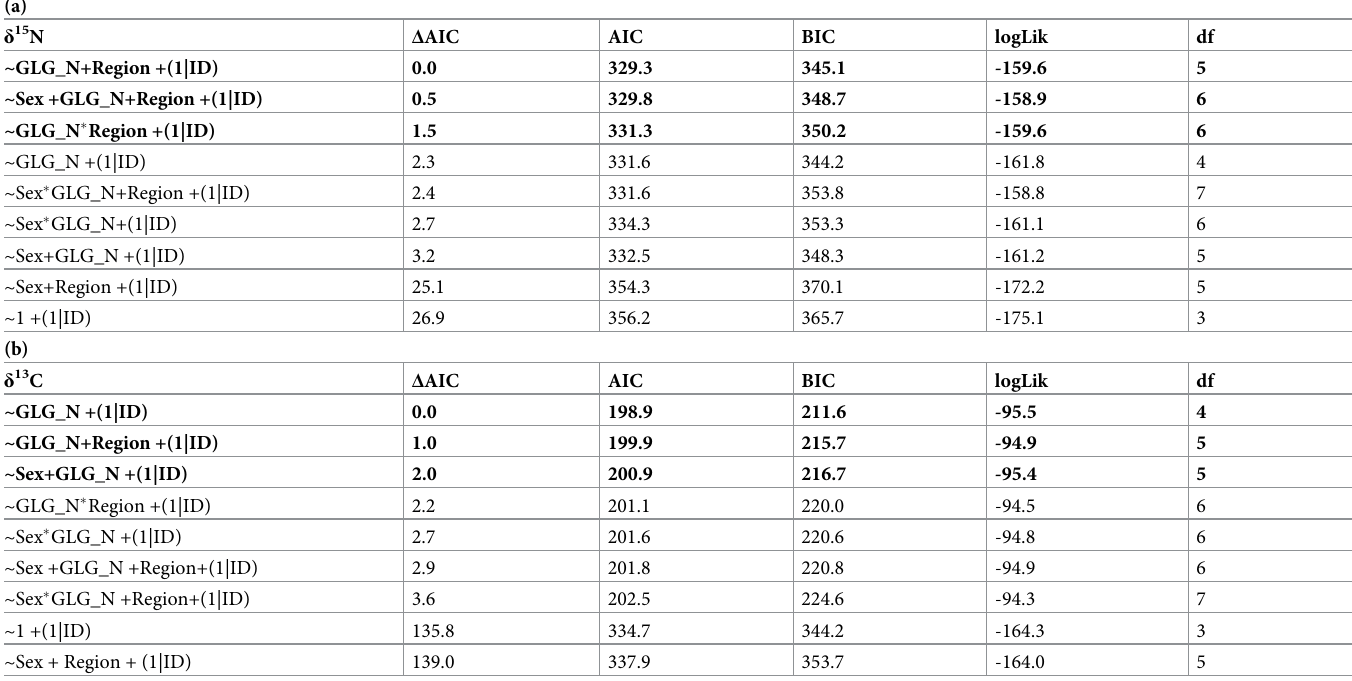
Table 2. Mixed effect model results comparisons for (a) δ 15 N and (b) δ 13 C. Best fit models are indicated in bold based on lowest AIC score and Δ AIC ≦ 2. BIC and Log Likelihood (logLik) scores with degrees of freedom (df) are included for comparison. “(1|ID)” indicates an individual effect.